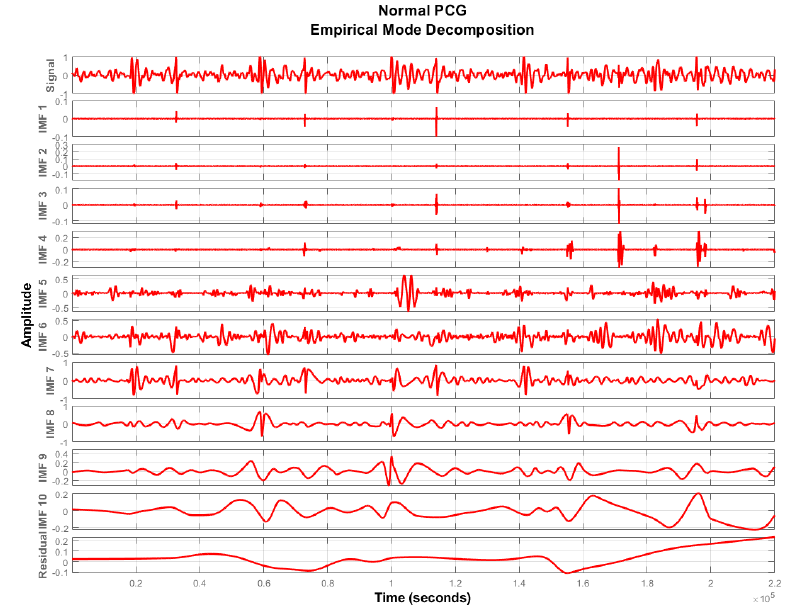
Figure 3. Intrinsic mode functions (IMFs) extracted from the PCG signal of a normal